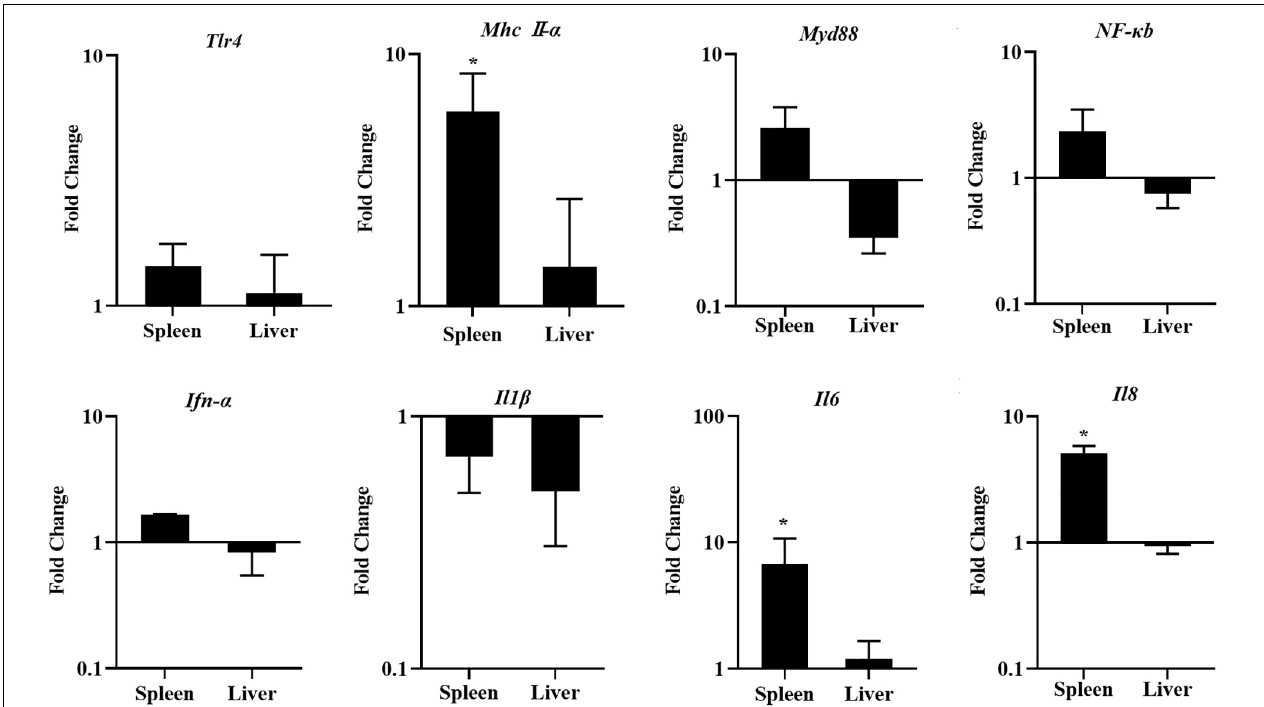
FIGURE 5 | The expression of Tlr4 , Mhc II- α , Myd88 , NF- κ B , Ifn- α , Il1 β , Il6 , and Il8 in the spleens and livers of chickens after 21 days of feeding. The fold change represents the target gene expression in the diet with LGG compared to the diet of the control group. The relative gene expression levels were normalized to β -actin . Bars represent the means ± standard deviations ( n = 5). * p < 0.05.